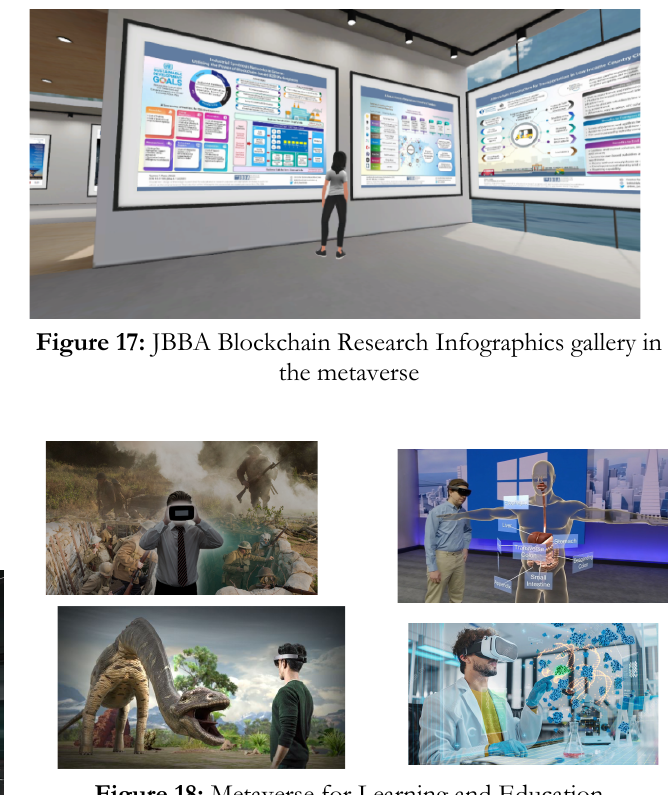
Figure 18: Metaverse for Learning and